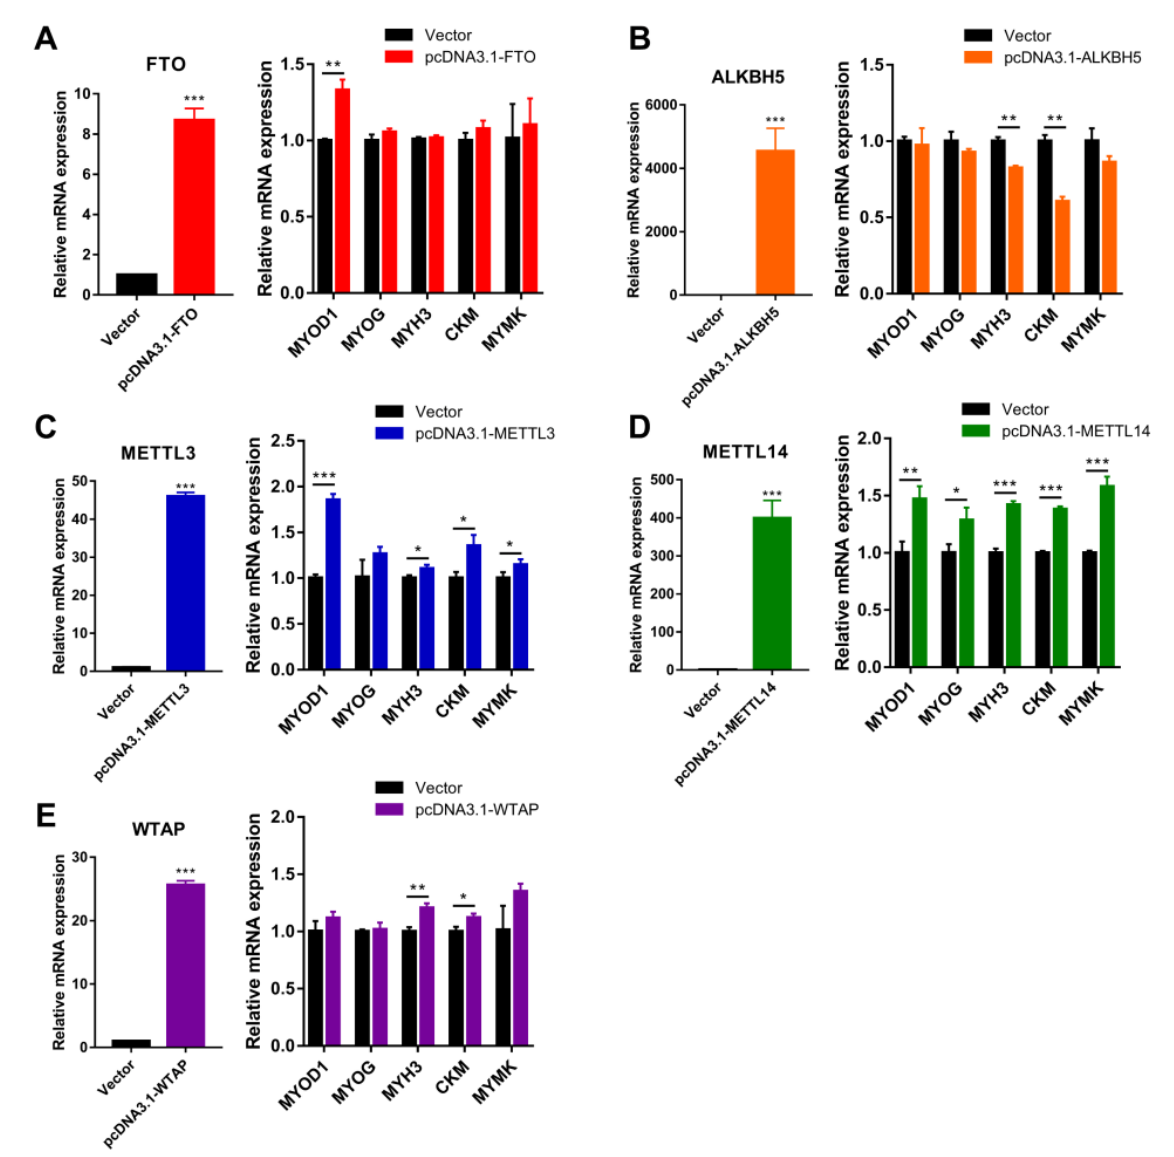
Figure 6. Overexpression of m 6 A methylase genes regulates bovine myoblast differentiation. Bovine myoblasts were induced for myogenic differentiation 24 h after transfection with empty vector or expression plasmids. ( A – E ) RT-qPCR was performed to detect the mRNA expression of ( A ) FTO , ( B ) ALKBH5 , ( C ) METTL3 , ( D ) METTL14 and ( E ) WTAP , reflecting the overexpression efficiency of the expressed plasmids after transfection. Then, the relative mRNA expression of MYOD1 , MYOG , MYH3 , CKM and MYMK on day 3 of myoblast differentiation was detected. GAPDH was the normalization control. Results are presented as the means ± SDs from three independent experiments.